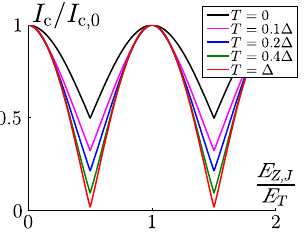
0 mode in a narrow FIG. 13. The critical current for the k x ¼ junction at different temperatures. As the temperature is in- creased, the contrast of the modulations is increased, with the n þ 1 = 2 Þ E minima at E becoming Z;J ¼ ð T